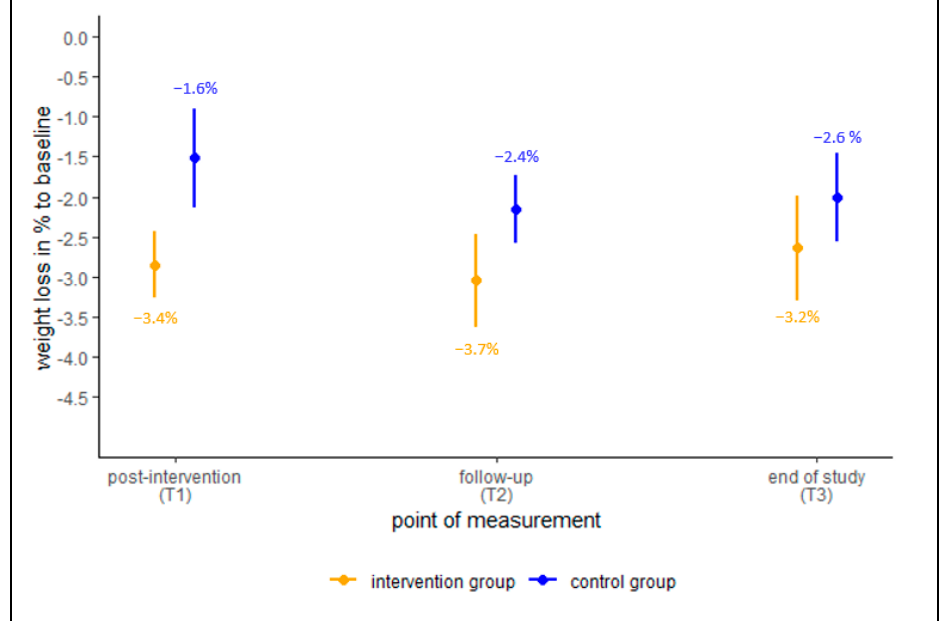
Figure 3. Mean change in weight loss in %, CCA data set, global mean with 95%-confidence intervals.